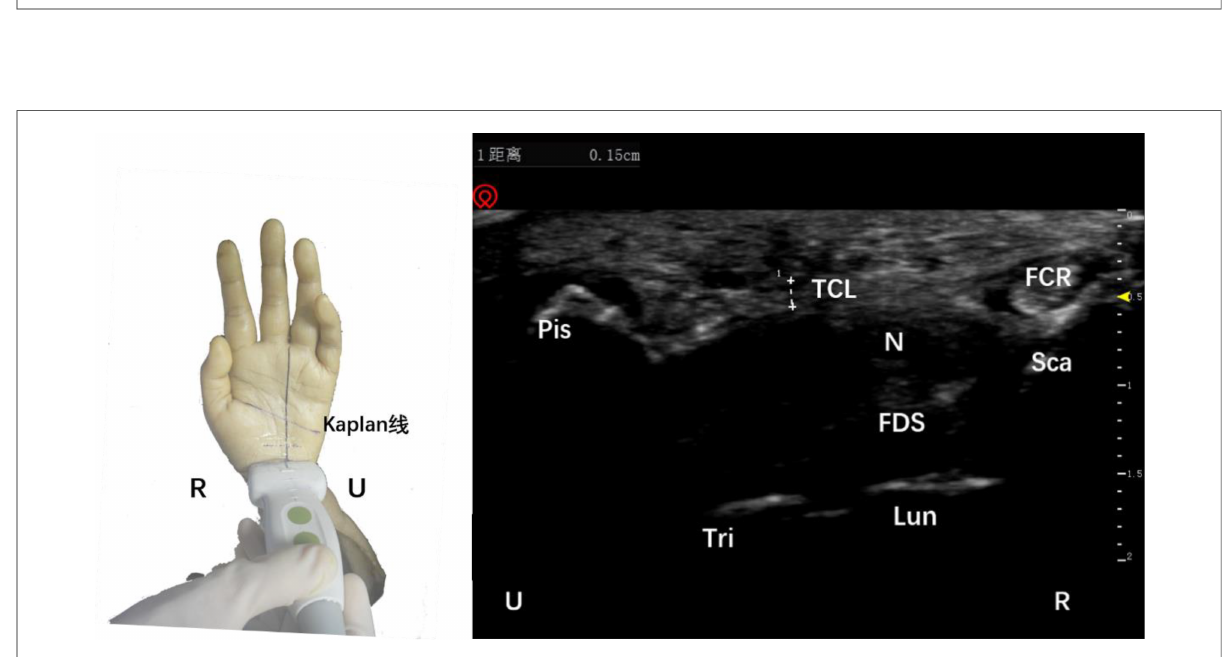
FIGURE 5 Schematic diagram of probe placement (left) and short-axis ultrasound display of the proximal boundary of the transverse carpal ligament (right). The plus sign refers to the width of the transverse carpal ligament. Pis, pisiform bone; TCL, transverse carpal ligament; FCR, fl exor carpi radialis; N, median nerve; FDS, fl exor digitorum super fi cialis; Tri, triquetral bone; Lun, lunate bone; R, radial; U,